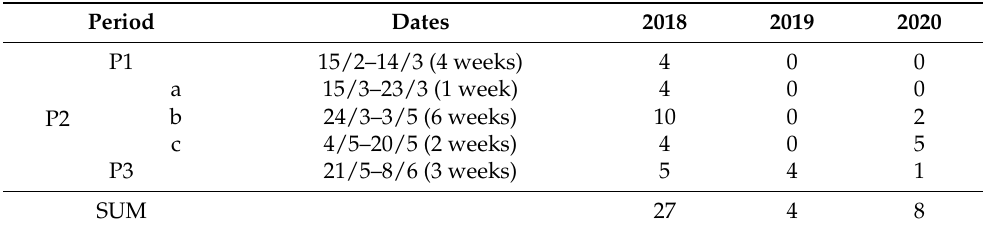
Table 4. The exceedances of the daily values of PM 10 for the years 2018, 2019 and 2020 by dividing the number of exceedances per